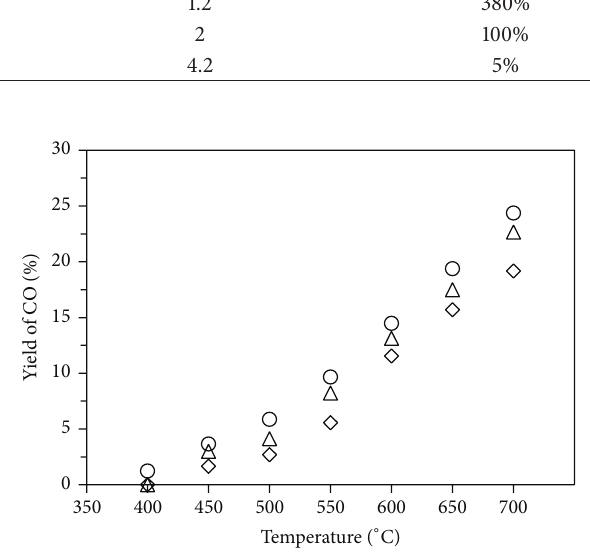
= 𝑃 = 1 kPa, balance H 2 CO 2